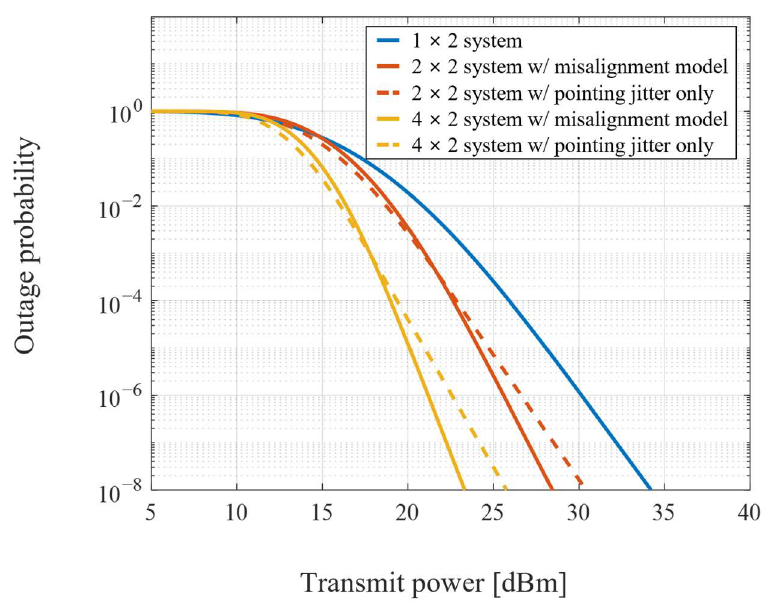
Figure 4. Outage performance of M × N systems for data reception at the ground terminal.